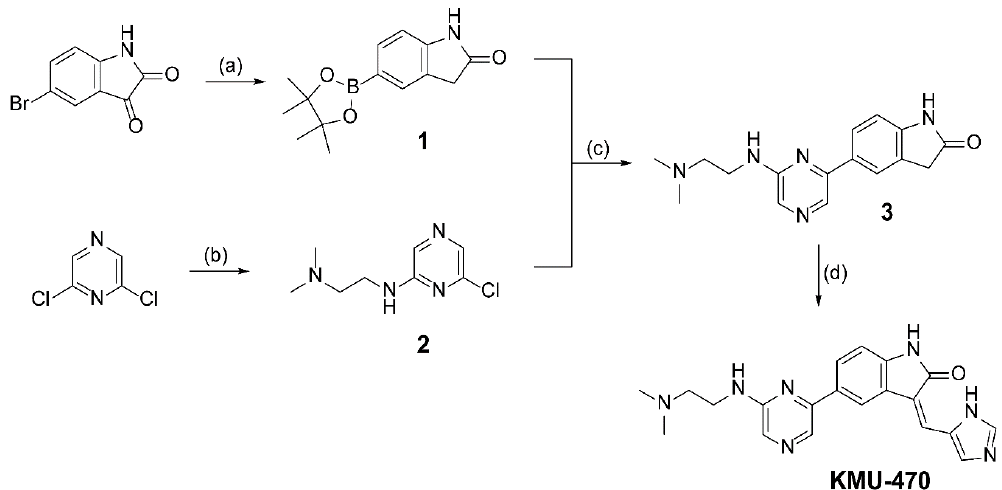
Figure 1. Reagents and experimental conditions: ( a ) i ) NH 2 NH 2 , NaOH, EtOH; ii ) bis(pinacolato)diboron, PdCl 2 (dppf), KOAc, 1,4-dioxane, microwave; ( b ) K 2 CO 3 , N , N -dimethylethylenediamine, DMF; ( c ) Pd(PPh 3 ) 4 , 2M K 2 CO 3 , 1,4-dioxane / EtOH (1:1.5), microwave; ( d ) piperidine, 1 H